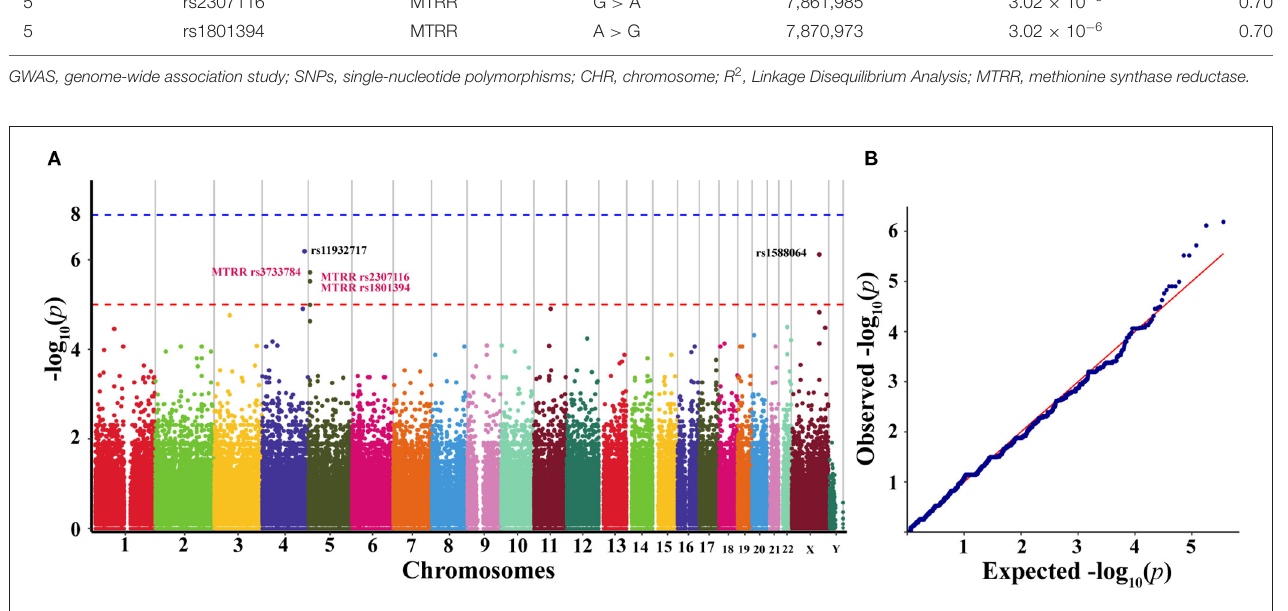
FIGURE 5 | Manhattan plot (A) and quantile-quantile plot (B) representing the results of the genome-wide association study (GWAS) of the discovery cohort ( n = 30). (A) Manhattan plot representing the association between SNPs and the susceptibility to agitation induced by sevoflurane anesthesia induction. The x-axis exhibits the